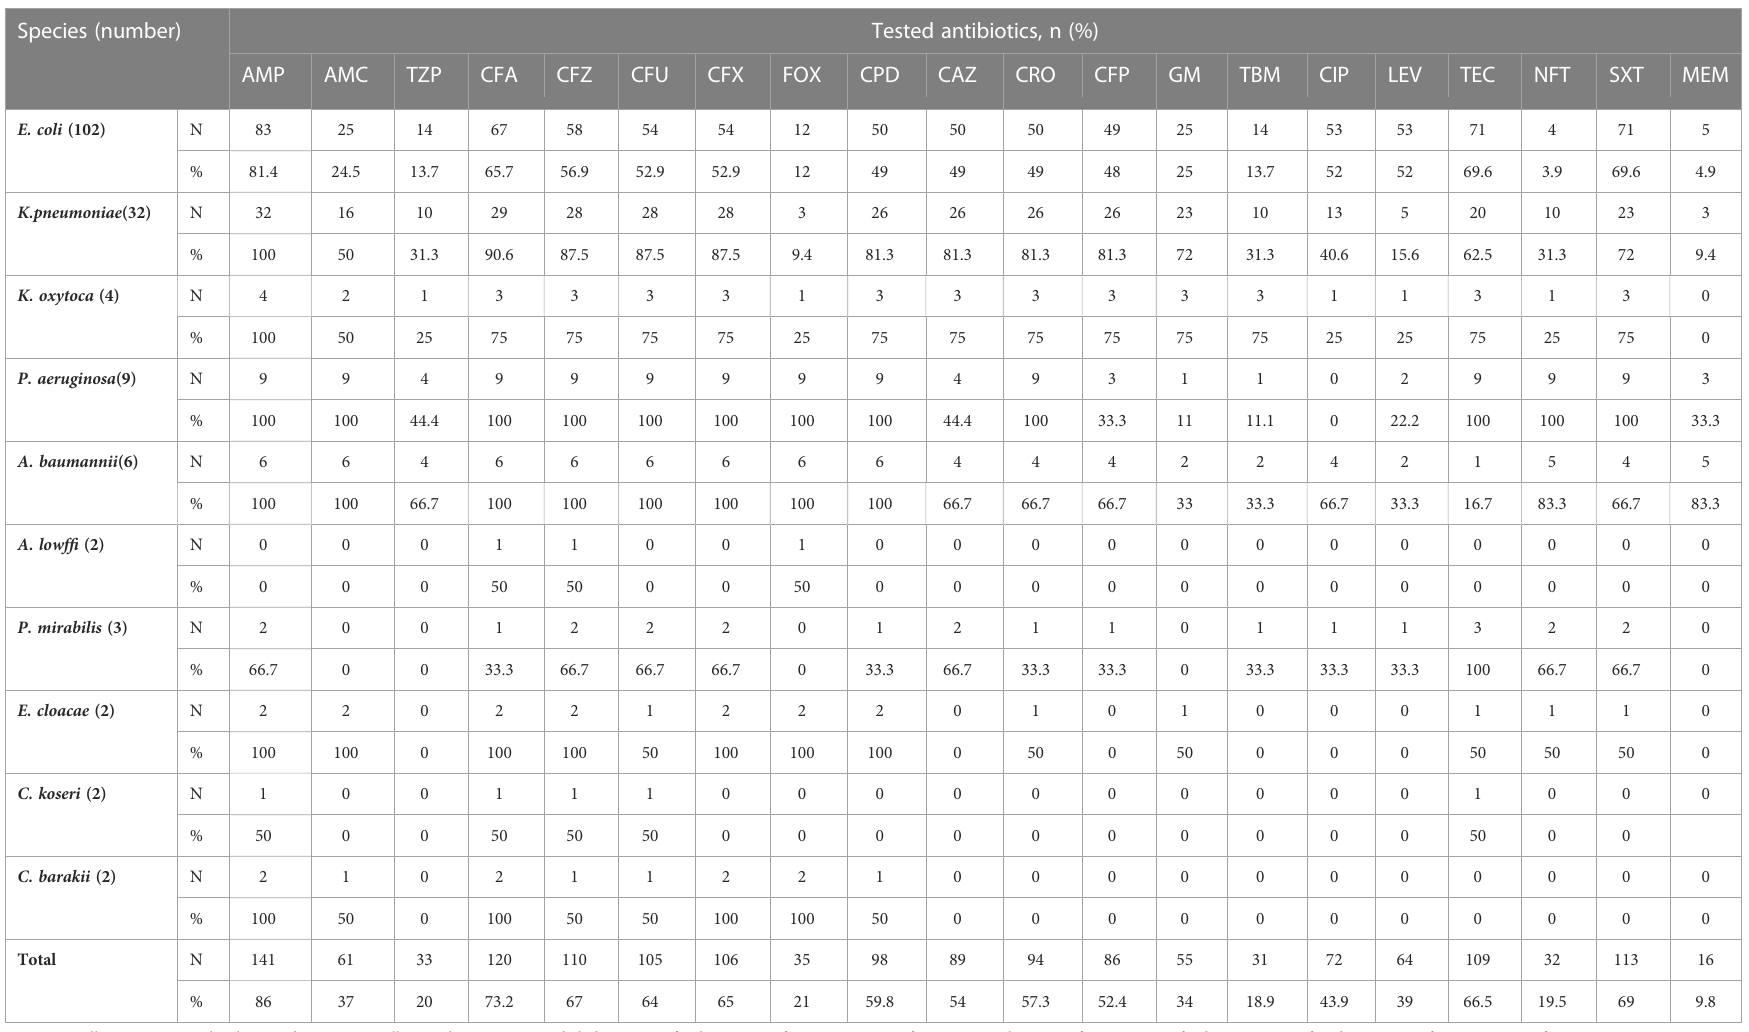
TABLE 3 Antimicrobial resistance pro fi le of isolates. Species